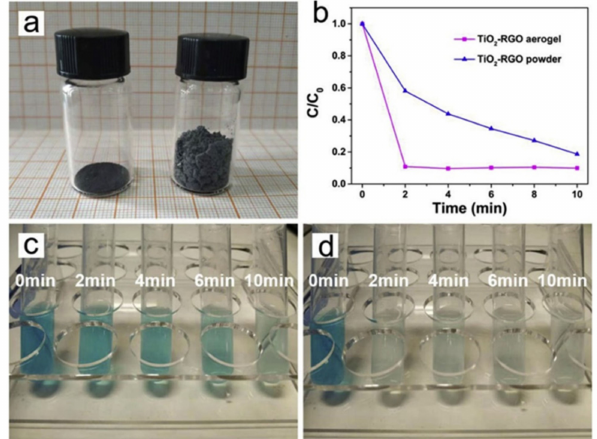
Figure 7. ( a ) Photograph of 80 mg TiO 2 -reduced graphene oxide (rGO) powder (left) and aerogel (right); ( b ) methylene blue (MB) dark adsorption results of the TiO 2 -rGO aerogel / powder; color changing of MB solution during dark adsorption with TiO 2 -rGO powder ( c ), and aerogel ( d ). All figures are reprinted from [77], with permission from Elsevier, 2020.